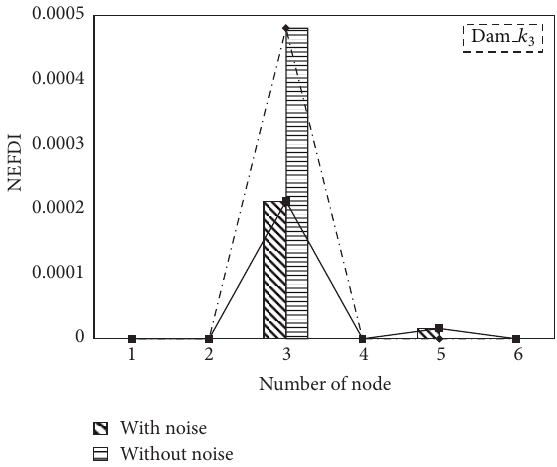
Figure 6: The effects of noise on NEFDI